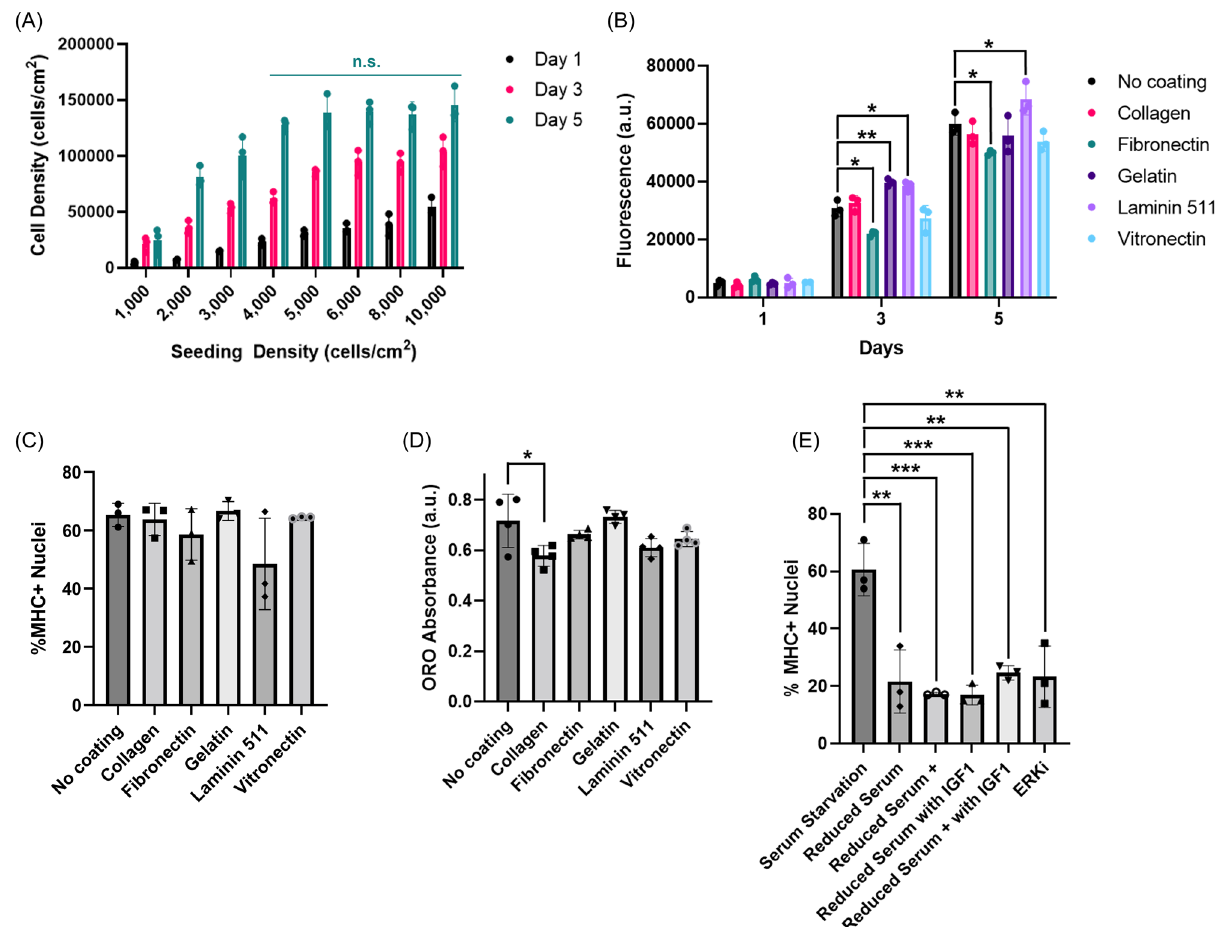
Figure 5. Cell culture optimization. ( A ) Comparative growth curves for varying seeding densities over days 1, 3, and 5. For day 5, two-way ANOVA indicated no significant differences between 4000, 5000, 6000, 8000, and 10,000 cell/cm 2 . ( B ) dsDNA quantification for Mack1 cells cultured on different ECM surface mimetics. Error bars indicate standard deviation, n = 3; statistical significance calculated by two-way ANOVA with multiple comparisons between the surface mimetics and the no coating control at each time point and indicated by asterisks, in which p < 0.05 (*) and p < 0.01 (**). ( C ) Percent MHC+ nuclei for Mack1 cells cultured on different ECM surface mimetics. Error bars indicate standard deviation, n = 3; statistical significance calculated by two-way ANOVA with multiple comparisons between the surface mimetics and the no coating control and indicated no significant differences between the mimetics. ( D ) Neutral lipid quantification, through Oil Red O extraction, for Mack1 cells cultured on different ECM surface mimetics. Error bars indicate standard deviation, n = 4; statistical significance calculated by two-way ANOVA with multiple comparisons between the surface mimetics and the no coating control and indicated by asterisks, in which p < 0.05 (*). ( E ) Percent MHC+ nuclei comparison between different muscle differentiation methods. Error bars indicate standard deviation, n = 3; statistical significance calculated by two-way ANOVA with multiple comparisons between differentiation methods and indicated by asterisks, in which p < 0.01 (**) and p < Beefy9 serum-free medium (data not shown) 38 and ERK inhibition (Fig. 5B) 2 were unsuccessful. To develop a serum-free medium for fish cell culture, media with mushroom extracts and insulin-like growth factor 2 (IGF-2) have shown promise in goldfish and medaka ( Oryzias latipes ) cultures, respectively 39,40 . However, neither medium promoted proliferation of Mack1 cells (data not shown). Additionally, while the Mack1 cells did not demonstrate a reliance on an ECM mimetic for cultivation (Fig. 5B), the surface coating screens should be revisited during serum-free media development, as the FBS includes proteins that likely adsorb onto tissue culture plastic and encourage cell adhesion. While demonstration of myogenic and adipogenic-like phenotypes underscore cell functionality, the con- tinued development of research tools to understand biological and molecular processes should accelerate pro- gress towards enhanced functional utility for these cells. While the Mack cells stained positively for PAX7 and MHC, staining with antibodies for MYOD and MYOG was unsuccessful (data not shown). The unsuccessful trials highlight the need for future research tool development, to both pose and answer questions regarding cell line function and development. For example, the RT-qPCR assay introduced questions regarding temporal gene and protein expression patterns in muscle differentiation, while the lack of PPARG gene expression in